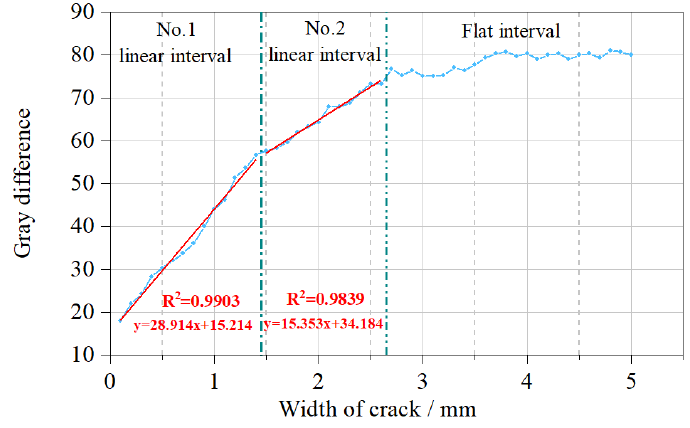
Figure 9. The relationship between the crack background difference and the crack width.